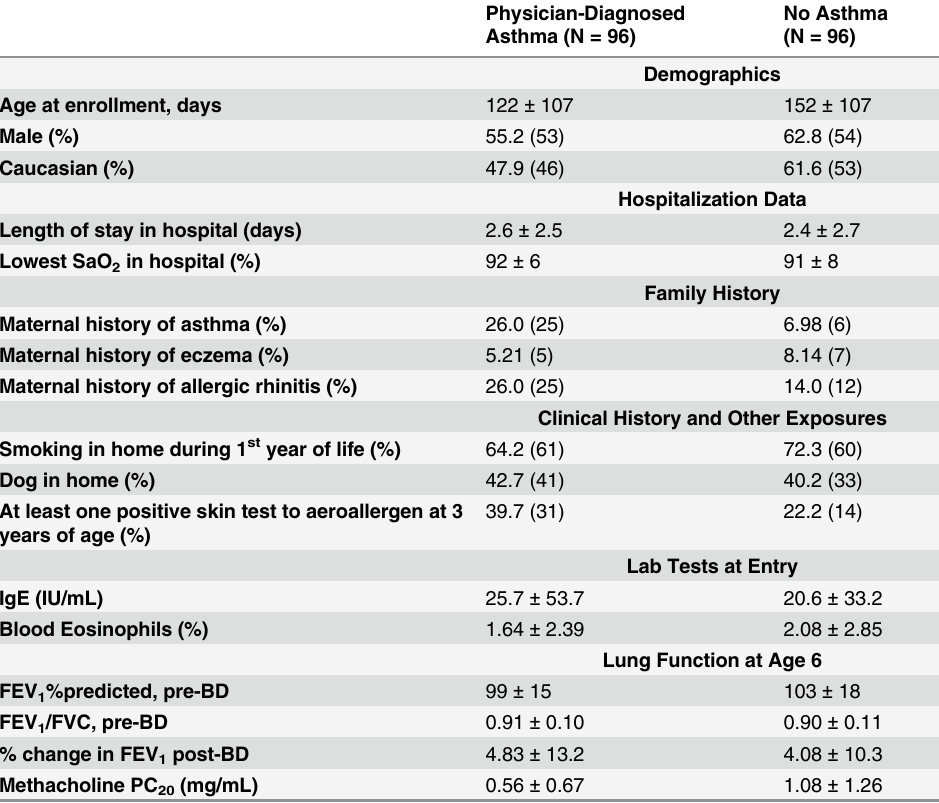
Table 1. Summary of clinical characteristics of participants in the RBEL